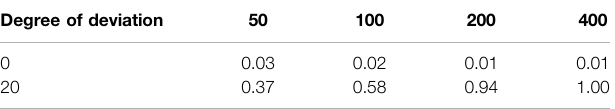
TABLE 2 | Power analysis and false positive rate of aHWE detection under different sample size. Degree of